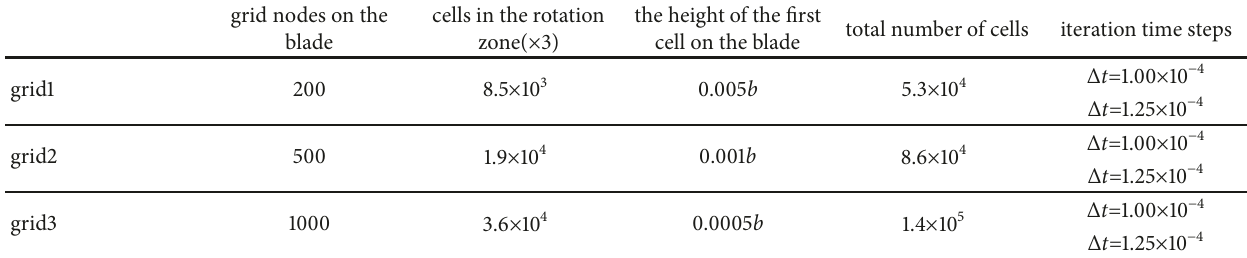
Figure 2: The mesh system with a stationary and a rotating domain. Table 1: Details of grid numbers and iteration time steps considered in this